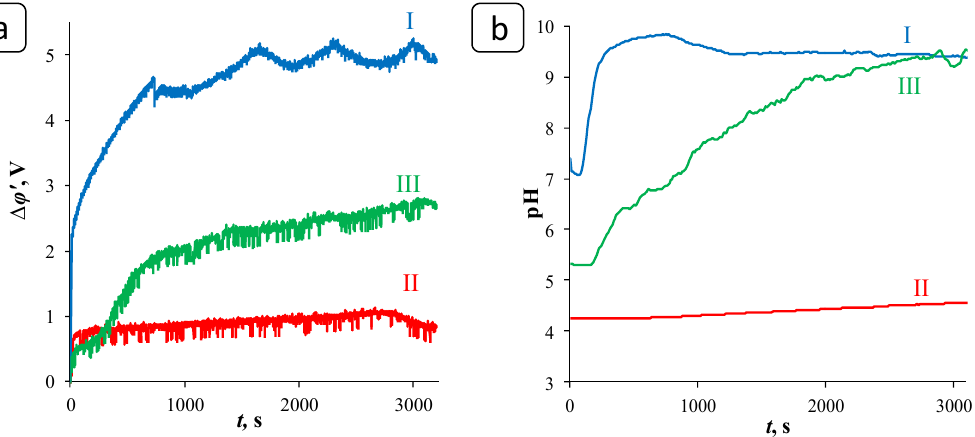
Figure 4. Fragments of chronopotentiograms ( a ) and time dependences of the pH value in the concentration compartment ( b ) for the blank experiment (I) and for experiments in the presence of PAA-F2 (II) and HEDP-F (III) in the constant current mode at i = 10 mA·cm − 2 .